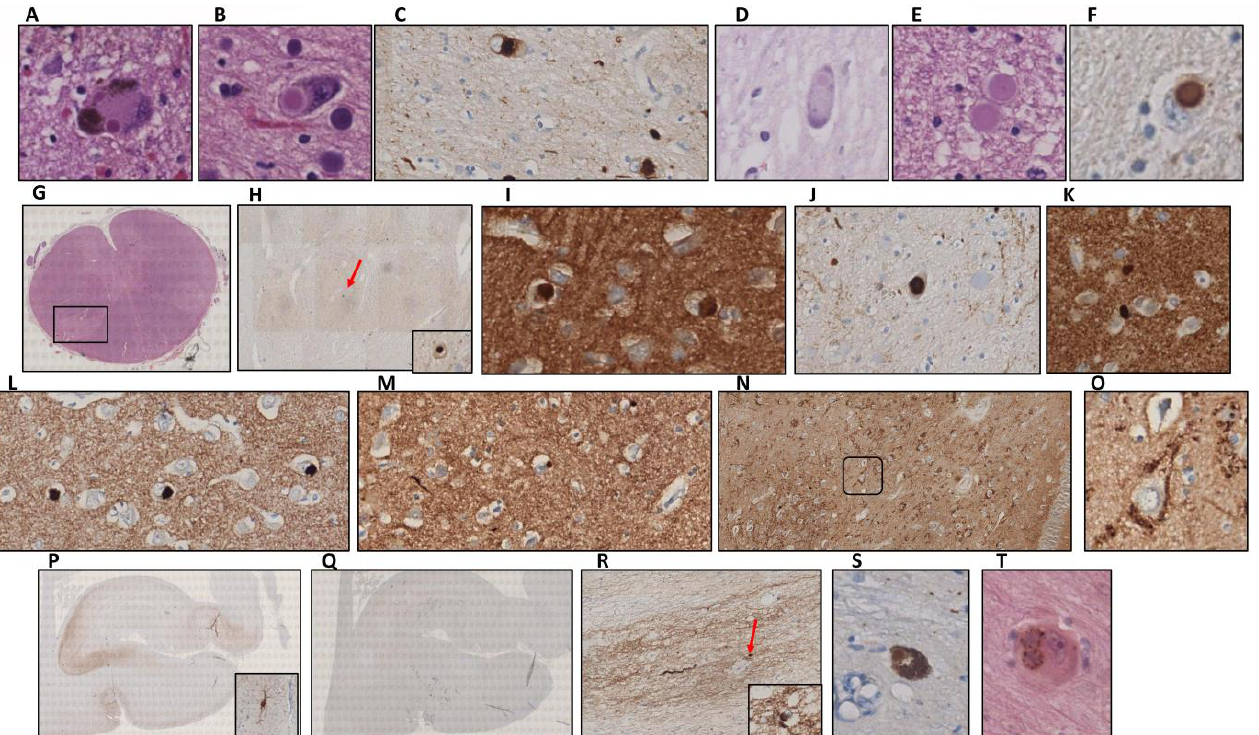
Figure 4. ( A,B ) Hematoxylin-eosin staining showing Lewy bodies in the locus coeruleus ( A ) and the nucleus basalis ( B ) at 40×. ( C ) Lewy bodies in the nucleus basalis marked for alpha-synuclein (40×). ( D , E ) Classical ( D ) and intraneuritic ( E ) Lewy bodies in the hypothalamus after hematoxylin-eosin staining (40×). ( F ) Lewy body in the hypothalamus marked for alpha-synuclein (40×). ( G ) Spinal trigeminal nucleus with the selected region for further study in a square. ( H ) Lewy body marked with alpha-synuclein from the region described in ( G ) (4× and zoomed area at 40×). ( I ) Lewy bodies in the cingulate cortex (40×). ( J , K ) Lewy bodies located in the striatum: putamen ( J ) and caudate ( K ) nuclei at 40×. ( L ) Lewy bodies in the amygdala (40×). ( M ) Lewy bodies in the subiculum (40×). ( N ) Alpha-synuclein aggregates on the neuronal soma membranes in the hippocampal CA3 subfield (10×). ( O ) Zoomed area of the region highlighted in ( N ) (40×). ( P ) Hippocampal tau deposits (2×) with a neurofibrillary tangle in a zoomed square. ( Q ) Absence of beta-amyloid deposition in the hippocampus (2×). ( R ) Dystrophic neurites in the olfactory bulb (10×) (Lewy body in a square). ( S ) Ubiquitin deposit in a Lewy body from the substantia nigra (40×). ( T ) p38MAPK deposition in multiple Lewy bodies located in the basal nuclei (80×).